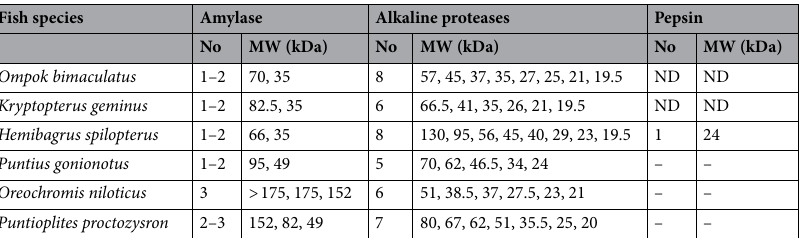
Table 2. Number of isoenzyme and the estimated molecular weight of amylase, alkaline protease and pepsin- like enzyme. ND: not detectable.